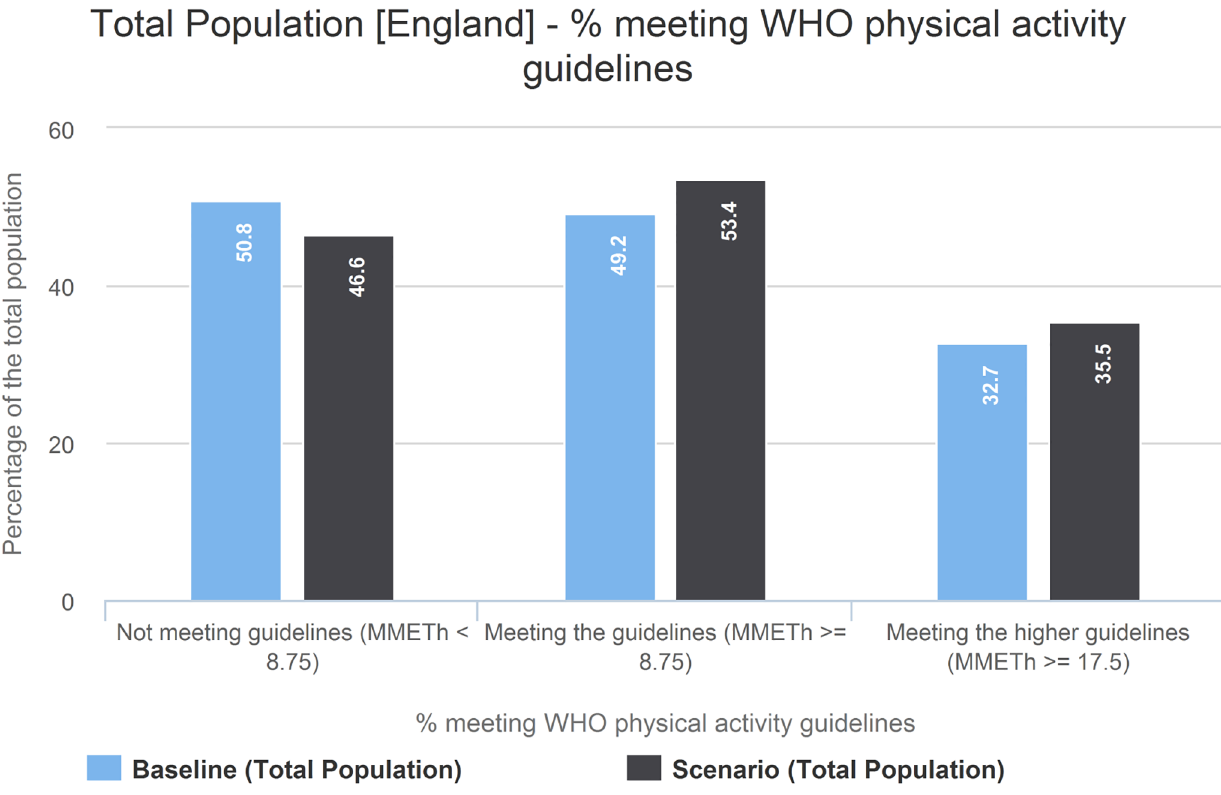
Fig 6. Percentage of the population achieving minimum recommended physical activity per week. Exemplar scenario with 25% regular cyclists, equity off, e-bikes off.